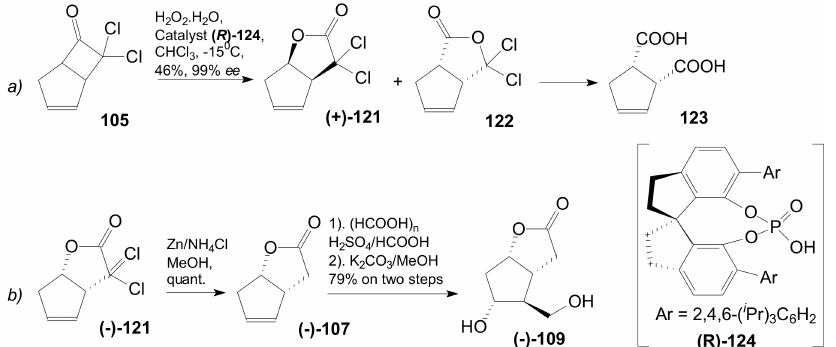
ing two steps for obtaining the Corey γ -lactone ( − )-109 . Route ( a ): stereo-controlled organometalic Baeyer-Villiger oxidation; route ( b ): The transformation of enantiomer ( − )-121 into Corey γ -lactone ( − )-109 . The Corey lactone 95 is oxidized to aldehyde and used for building the ω -side chain by an E -HEW selective olefination. The aldehyde from 95 can be protected as dimethyl acetal